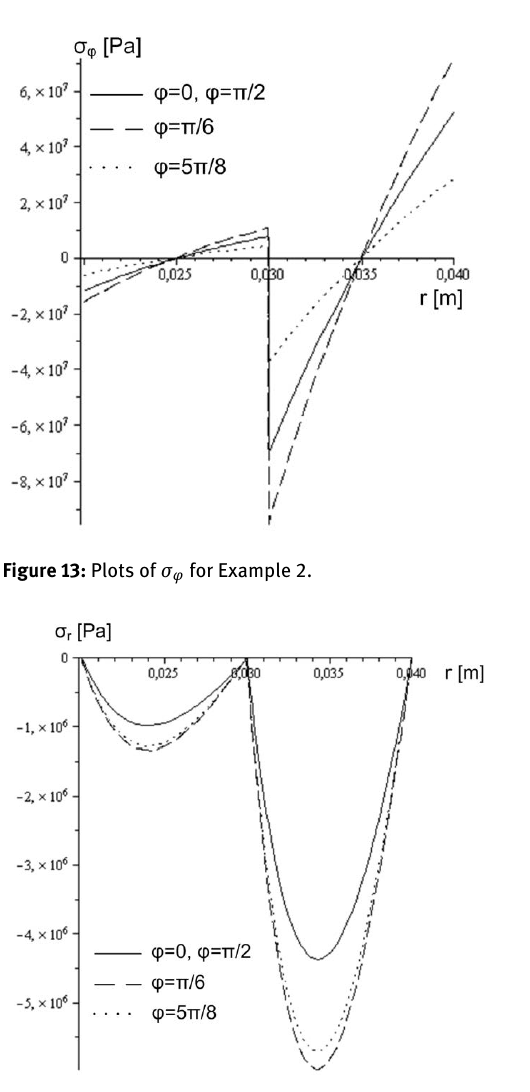
Figure 14: Plots of σ r for Example 2.